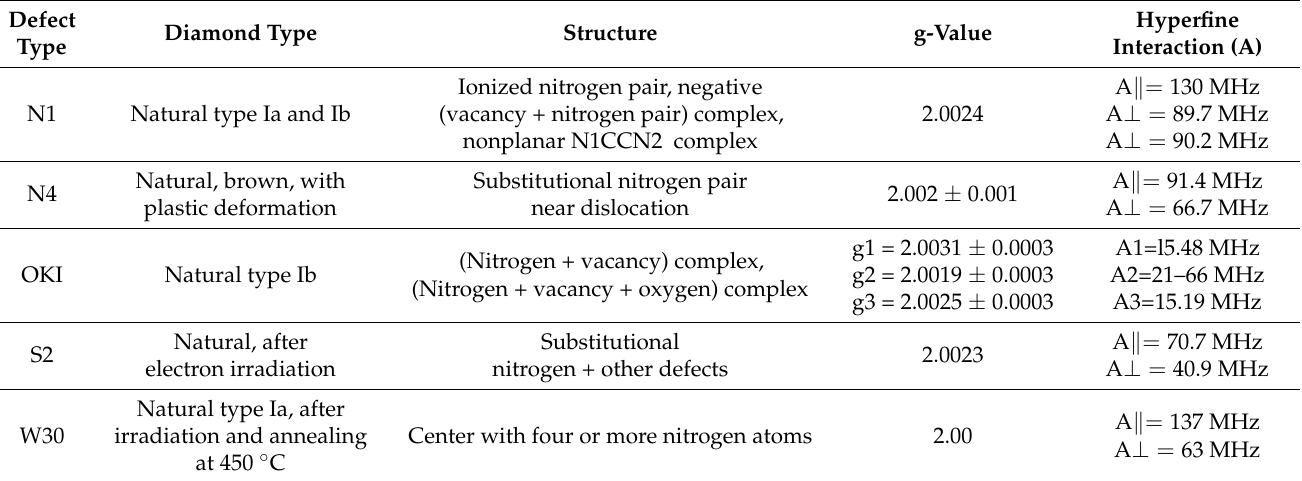
Table 2. Examples of known carbon-centered paramagnetic species of different diamond